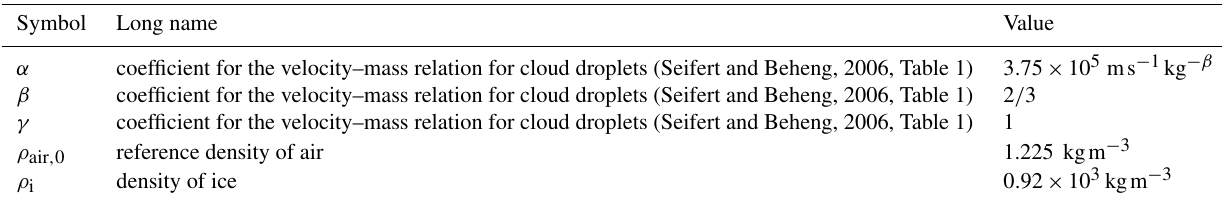
Table 2. Constants used in the sublimation calculations for a sphere as described in the text. For a comprehensive list, see also Table A2. Note that the parameterization for the velocity–mass relation for cloud droplets from Seifert and Beheng (2006) is used for spherical ice crystals in this study. Constants that differ for a hexagonal plate or rosette crystal are given in Tables A4 and A6. Symbol coefficient for the velocity–mass relation for cloud droplets (Seifert and Beheng, 2006, Table 1)